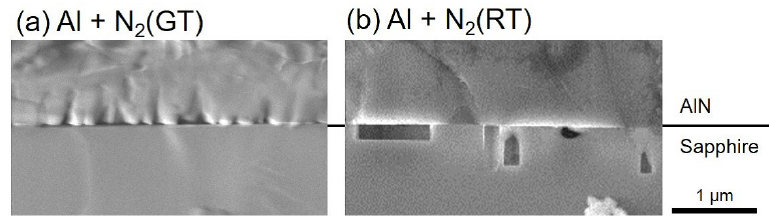
Figure 3. Cross-sectional images near the interfaces of AlN films on sapphire grown with Al + Processes ( a ) N 2 (GT) and ( b ) N 2 (RT).